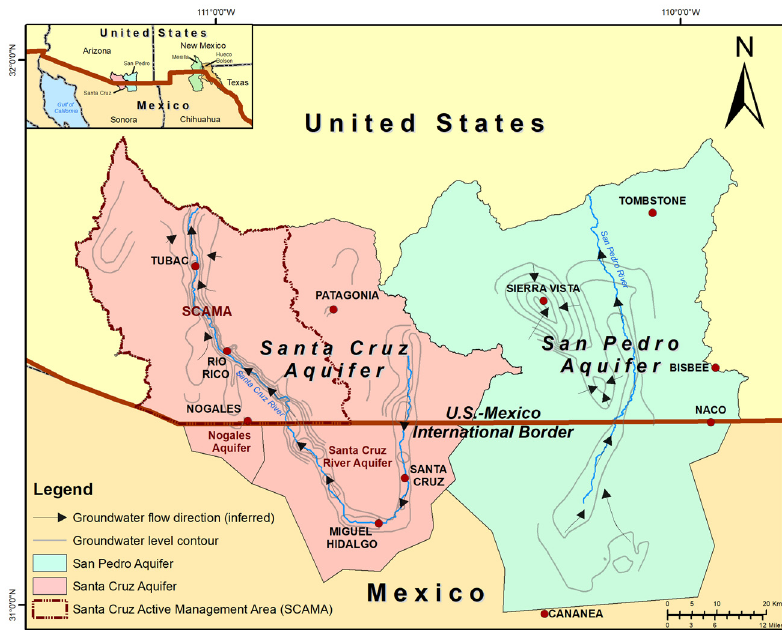
Figure 3. The Santa Cruz and San Pedro aquifers.